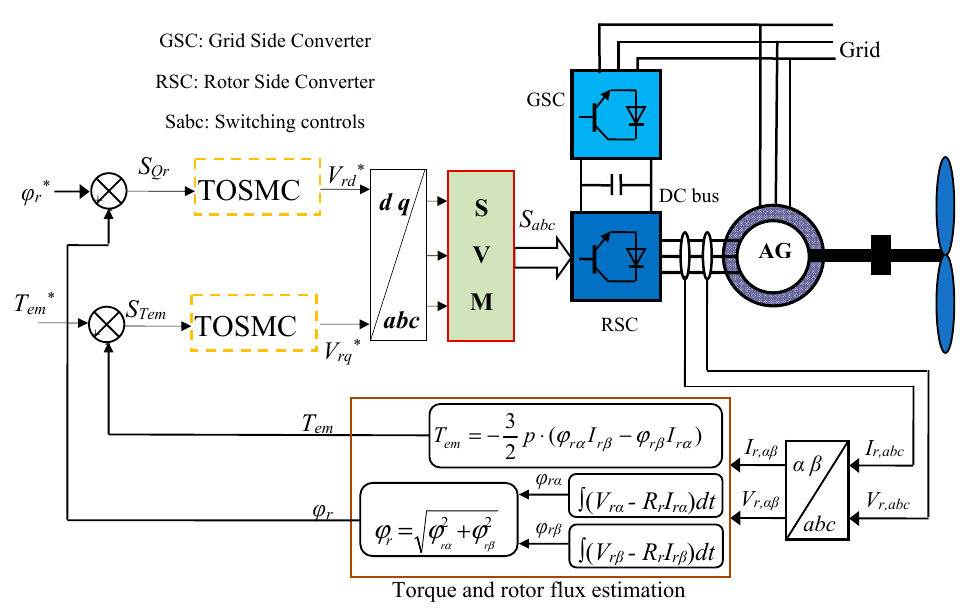
Figure 3. Bloc diagram of the AG with the DFTC-TOSMC method. 288